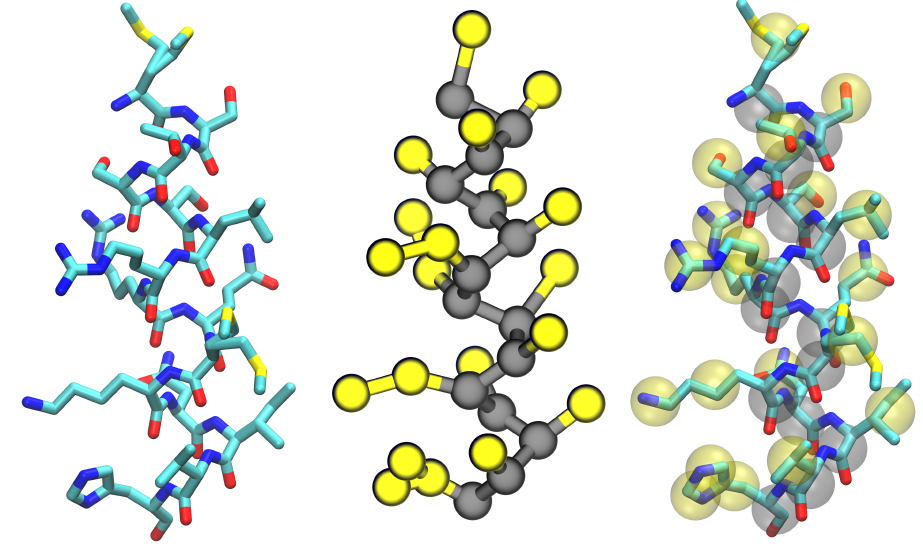
An example protein helix in all-atom (left) and Martini coarse-grained representations (center, backbone beads in gray and side-chain beads in yellow) with both images merged (right) to show how the fine-grained structure is mapped onto the coarse-grained beads. This image was rendered with Visual Molecular Dynamics